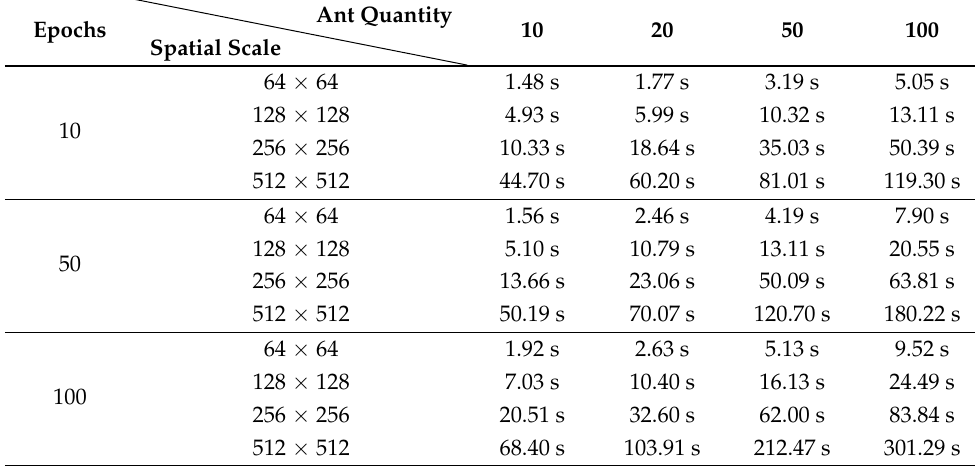
Table 2. Ant colony optimization in nonuniform space.